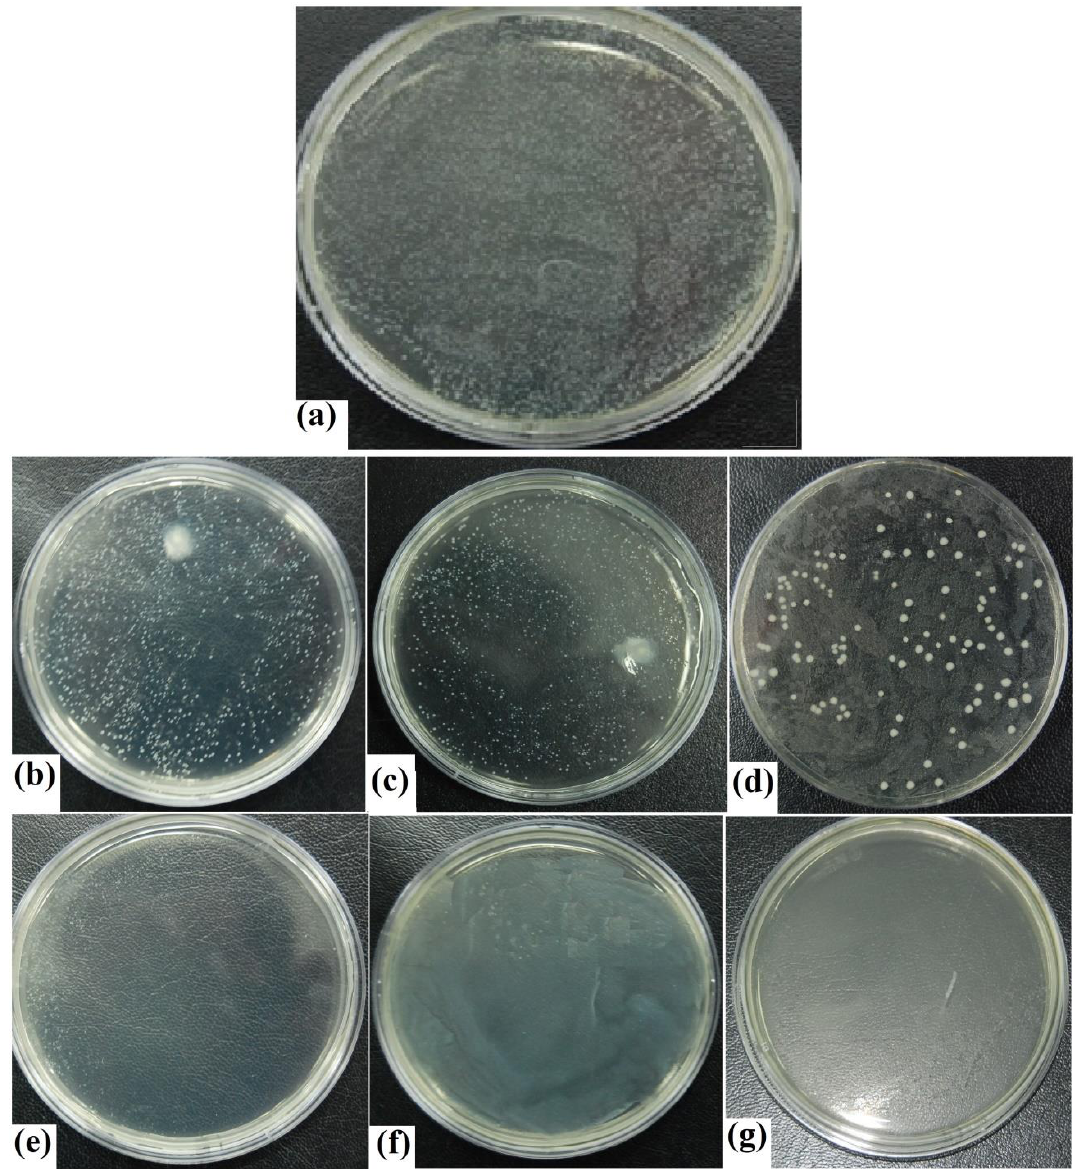
Figure 4. (Color online). Visual analysis of V. cholera CFUs. ( a ) Pure V. cholera strain 10 7 CFUs; ( b ) CFUs after 15 s plasma treatment without H 2 O 2 vapors; ( c ) CFUs after 30 s plasma treatment without H 2 O 2 vapors; ( d ) CFUs after 45 s plasma treatment without H 2 O 2 vapors; ( e ) CFUs after 15 s plasma treatment at 0.1 mbar air pressure and 5.9 sccm flow of vaporized H 2 O 2 ; ( f ) CFUs after 30 s plasma treatment at 0.1 mbar air pressure and 5.9 sccm flow of vaporized H 2 O 2 ; and ( g ) CFUs after 45 s plasma treatment at 0.1 mbar air pressure and 5.9 sccm flow of vaporized H 2 O 2 .